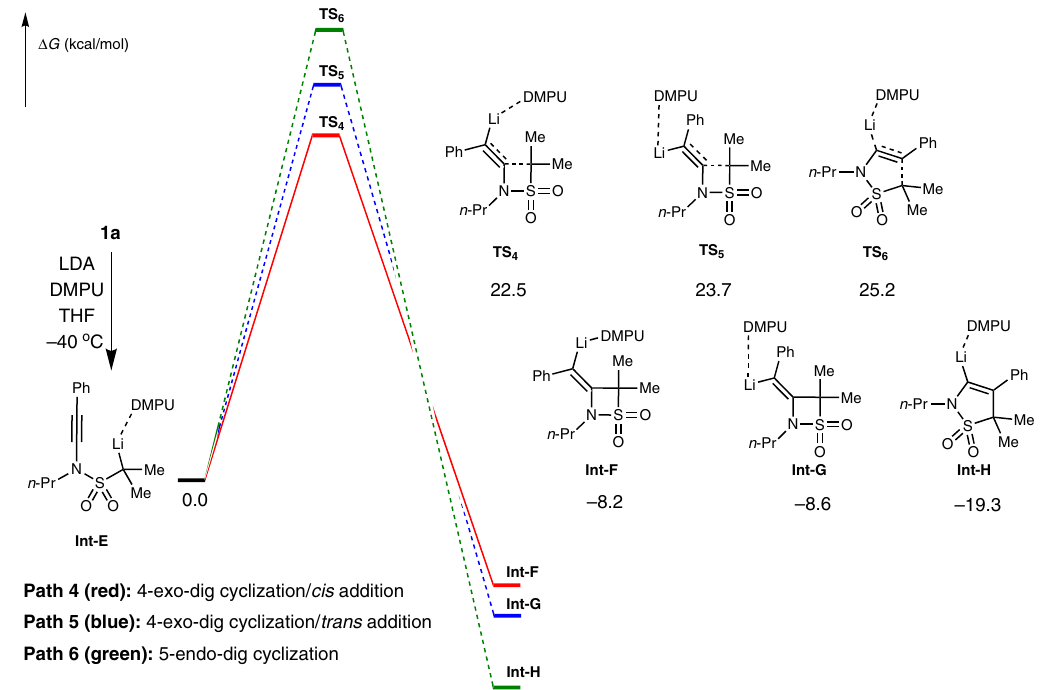
Fig. 8 DFT calculations for the LDA/DMPU-mediated cyclization in the skeleton reorganization. Free energy pro fi les (kcal/mol) of three possible cyclizations from Int-E . path 4 (red): 4-exo-dig cyclization/ cis addition leading to Int-F (via TS 4 ), path 5 (blue): 4-exo-dig cyclization/ trans addition leading to Int-G (via TS 5 ), path 6 (green): 5-endo-dig cyclization leading to Int-H (via TS 6 ).